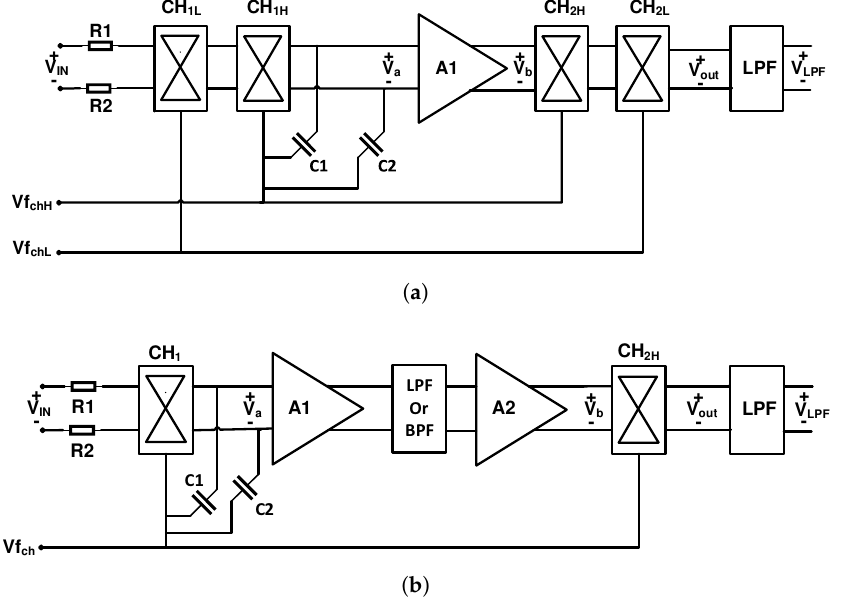
Figure 8. ( a ) Schematic of the nested chopper amplifier technique; ( b ) Schematic of the Spike filtering